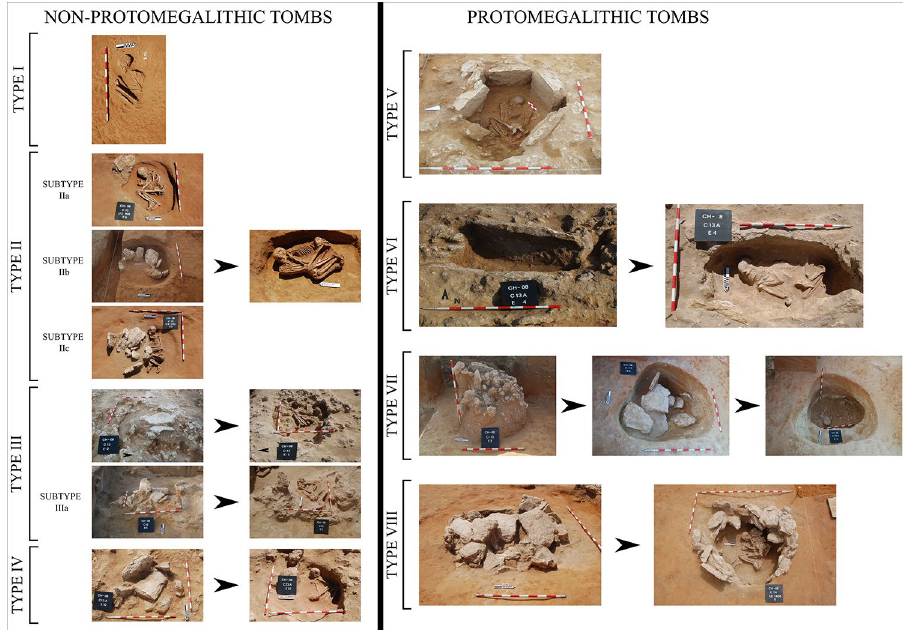
Figure 2. Typology of funerary structures at the Campo de Hockey necropolis. To the left, typology of non proto-megalithic tombs, and to the right typology of proto-megalithic tombs, in order of